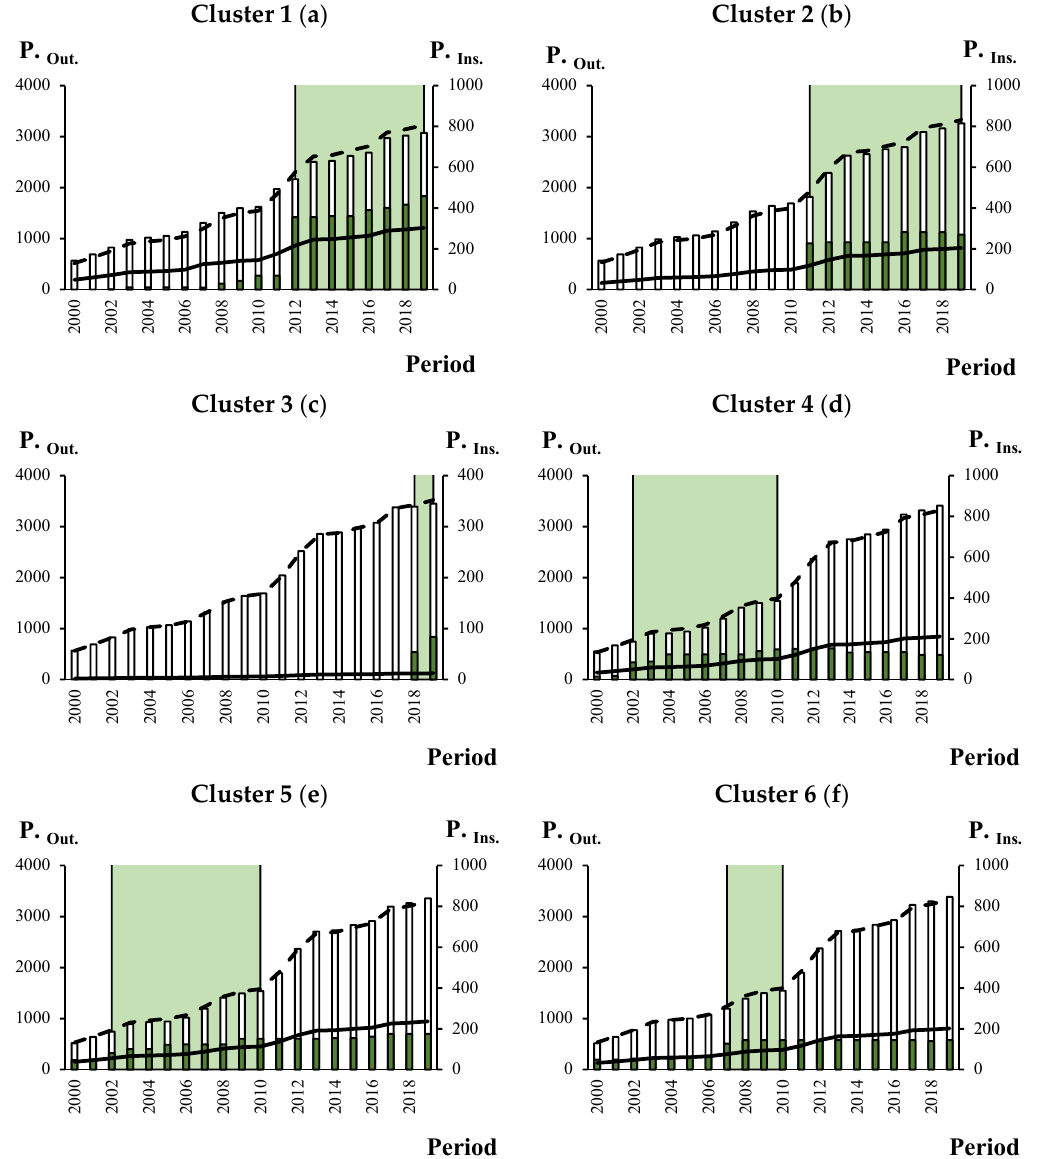
Period Figure 3. Evolution of granted power (MegaWatts-MW), observed and expected, outside (P.Out.) Figure 3. Evolution of granted power (MegaWatts-MW), observed and expected, outside (P.Out.) Figure 3. Evolution of granted power (MegaWatts-MW), observed and expected, outside (P.Out.) Figure 3. Evolution of granted power (MegaWatts-MW), observed and expected, outside (P.Out.) Figure 3. Evolution of granted power (MegaWatts-MW), observed and expected, outside (P.Out.) Figure 3. Evolution of granted power (MegaWatts-MW), observed and expected, outside (P.Out.) and inside (P. Ins.) of forest-based power plants clusters in Brazil, 2000–2019. Pot. expected and inside (P. Ins.) of forest-based power plants clusters in Brazil, 2000–2019. Pot. expected and inside (P. Ins.) of forest-based power plants clusters in Brazil, 2000–2019. Pot. expected and inside (P. Ins.) of forest-based power plants clusters in Brazil, 2000–2019. Pot. expected and inside (P. Ins.) of forest-based power plants clusters in Brazil, 2000–2019. Pot. expected and inside (P. Ins.) of forest-based power plants clusters in Brazil, 2000–2019. Pot. expected Figure 3. Evolution of granted power (MegaWatts-MW), observed and expected, outside (P.Out.) inside the cluster, Pot. expected outside the cluster, Pot. observed inside the cluster, inside the cluster, Pot. expected outside the cluster, Pot. observed inside the cluster, inside the cluster, Pot. expected outside the cluster, Pot. observed inside the cluster, inside the cluster, Pot. expected outside the cluster, Pot. observed inside the cluster, Pot. expected outside the cluster, inside the cluster, Pot. expected outside the cluster, Pot. observed inside the cluster, and inside (P. Ins.) of forest-based power plants clusters in Brazil, 2000–2019. Pot. expected Pot. observed outside the cluster, Cluster. Pot. observed outside the cluster, Cluster. Pot. observed outside the cluster, Cluster. Pot. observed outside the cluster, Cluster. Pot. observed outside the cluster, inside the cluster, Pot. expected outside the cluster, Pot. observed inside the cluster, Pot. observed outside the cluster, Cluster.